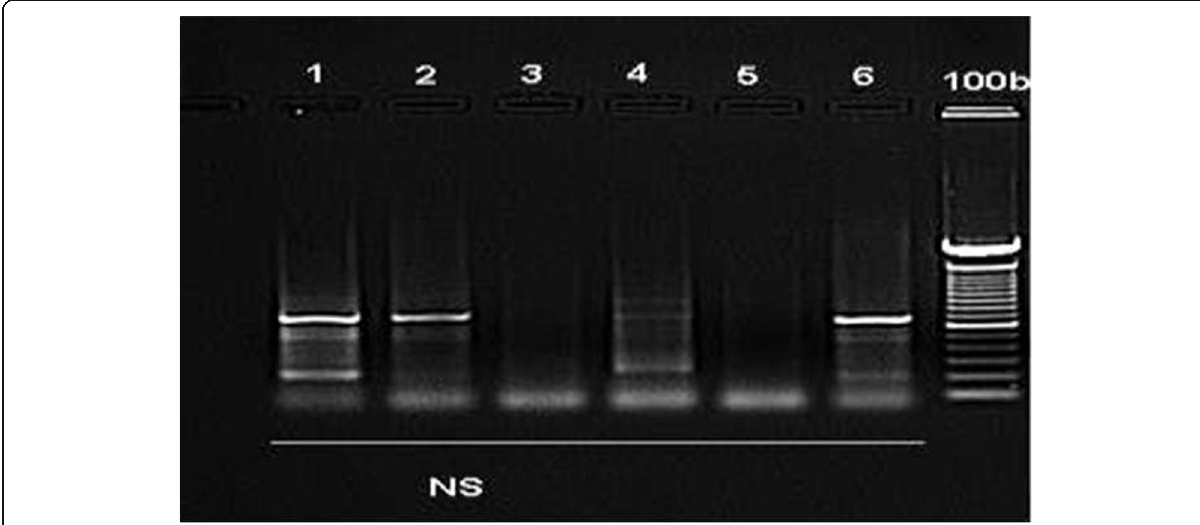
Fig. 2 1.5% agarose gel electrophoresis of the RT-PCR amplification products for the gene encoding the NS protein from different samples. 1, A/ equine/Essaouira/2/2004; 2, A/equine/Nador/1/1997; 3 – 5, BEV isolates (bovine enteric virus) used as a negative control; 6,